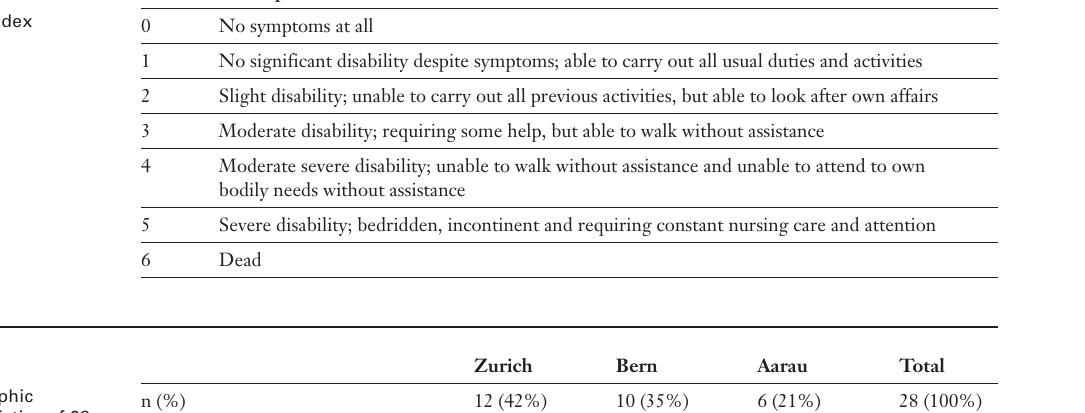
Demographic characteristics of 28 patients undergoing decompressive craniectomy after cerebral infarction